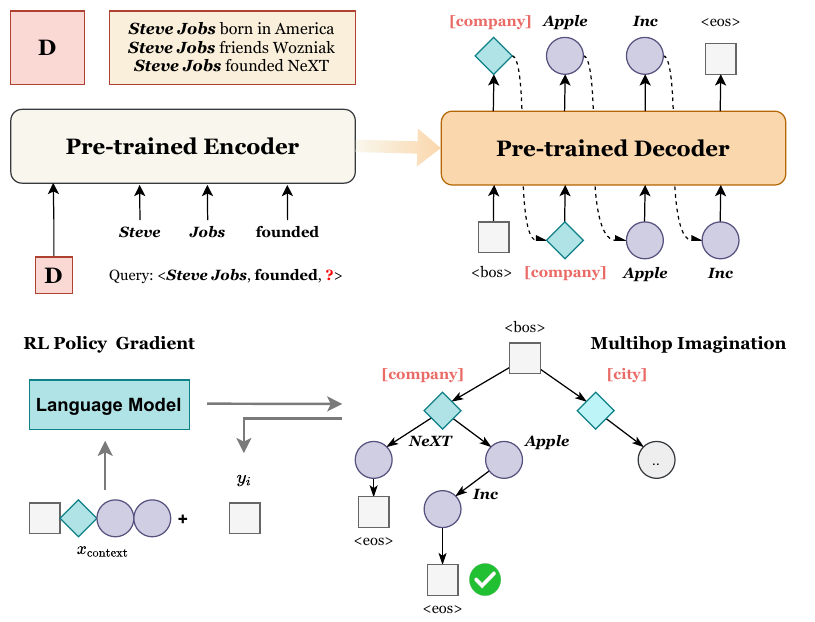
Figure 2. The architecture of the proposed model of the generative transformer with knowledge- guided decoding (GTK) for academic knowledge graph completion. We utilize a sequence-to- sequence-based architecture with a pre-trained transformer and leverage knowledge guidance in the input and during